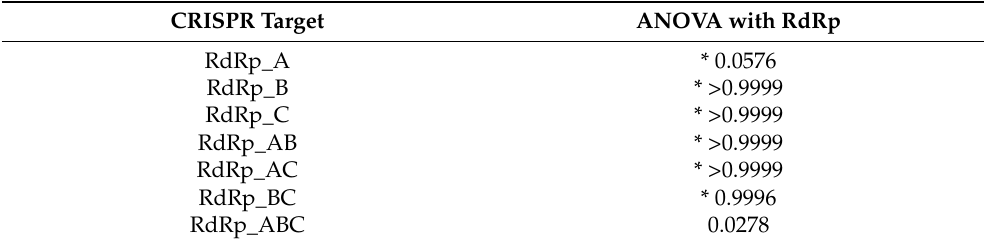
Figure 6. RdRp gRNA mismatch comparison. Data presented as the mean of triplicate replicates with error bars representing the standard error. Graphs in the top row compare number of SNPs while graphs on the bottom compare the SNP location at Day 2 post-infection. Table 7. One-way ANOVA comparison of RdRp gRNA mismatches. p values with an asterisk indicate the percent reduction is not significantly different from that of the RdRp control